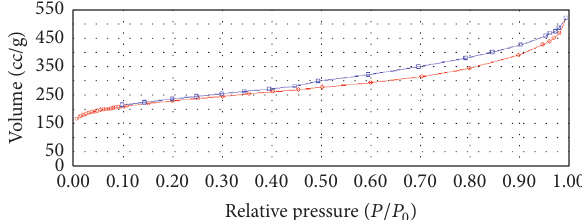
Figure 7: Adsorption/desorption of nitrogen gas on PAC-CNF.